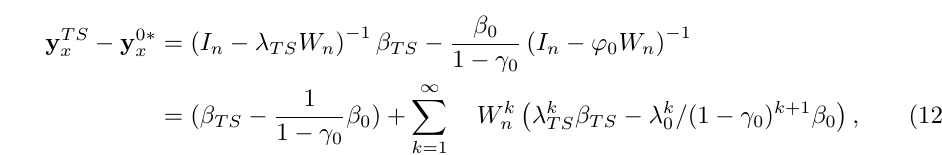
Note : Bias of Team Spatial relative to the corresponding marginal effects in the true model. Column three ( λ 0 = 0) of indirect long-run effects measures absolute bias because the true effect is nil. λ 0 denotes spatial dependence, γ 0 represents time